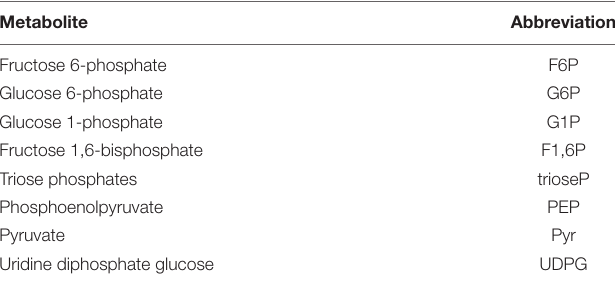
TABLE 3 | Abbreviations used for glycolytic intermediates characterized during 60 days storage.